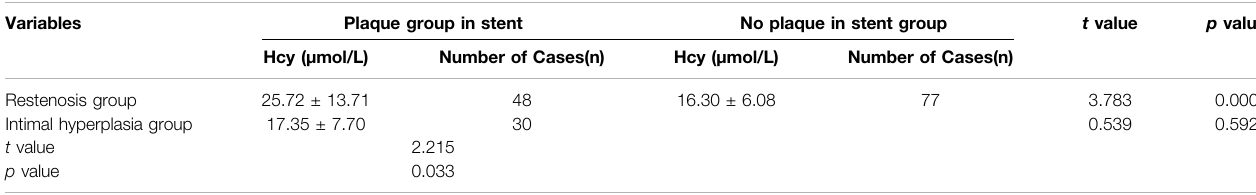
TABLE 4 | Comparison of serum Hcy levels between plaque group and plaque free group in stent. Variables